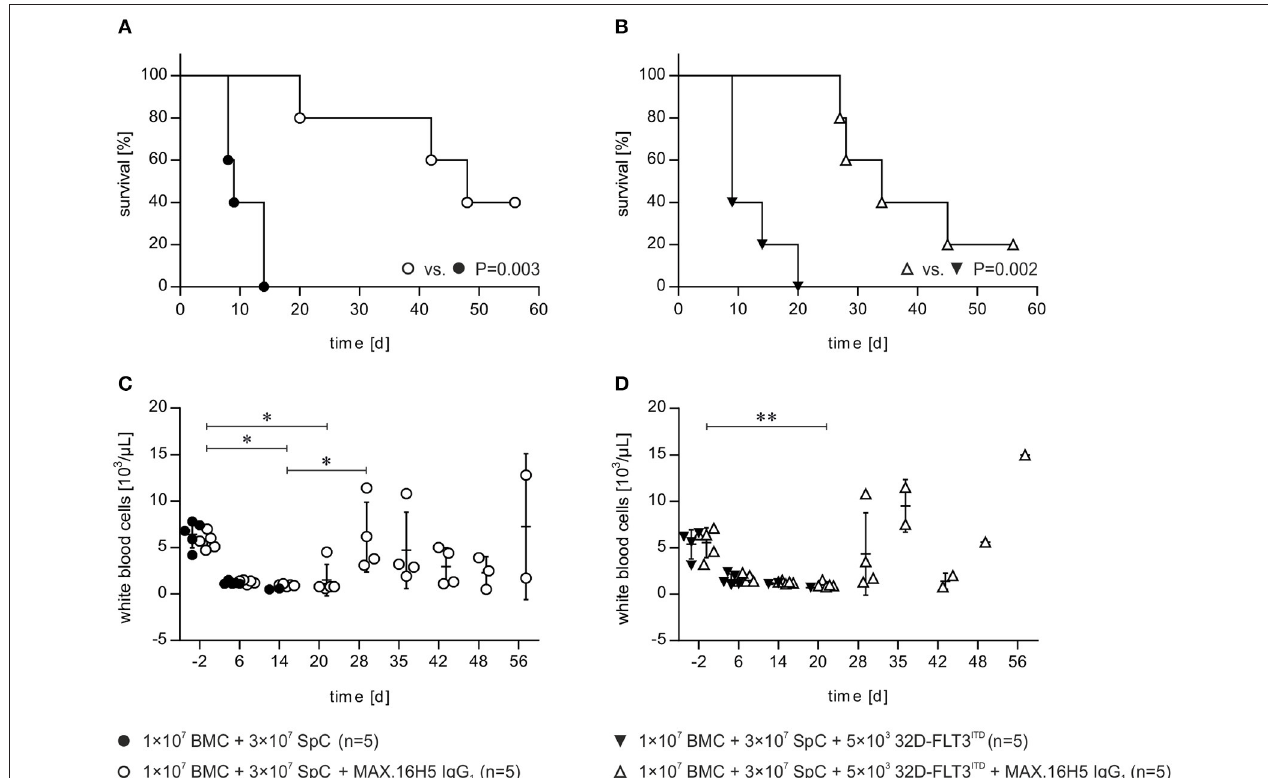
FIGURE 1 | Short-term pre-incubation of bone marrow and spleen cell grafts with MAX.16H5 IgG 1 antibody prolonged survival of C3H/HeN recipient mice after allogeneic transplantation either with or without co-transplantation of 32D-FLT3 ITD AML cells. All C3H/HeN mice received 1 × 10 7 bone marrow cells (BMC) and 3 × 10 7 spleen cells (SpC) as an allogeneic transplant in these experiments. (A) Survival of recipient mice after allogeneic transplantation. The grafts were pre-incubated either with MAX.16H5 IgG 1 or without antibody before administration to the recipients. C3H/HeN animals receiving a MAX.16H5 IgG 1 pre-incubated graft ( n = 5, open circles) showed a significantly prolonged survival compared to animals receiving an untreated graft ( n = 5, closed circles, P = 0.003; Log-Rank test). (B) Survival of C3H/HeN recipient mice receiving short-term pre-incubated (with or without MAX.16H5 IgG 1 antibody) grafts together with 5 × 10 3 32D-FLT3 ITD AML cells. C3H/HeN animals receiving a MAX.16H5 IgG 1 pre-incubated graft together with 32D-FLT3 ITD cells ( n = 5, open triangle) showed a statistically significant prolonged survival compared to animals receiving an antibody untreated graft ( n = 5, closed triangle, P = 0.002; Log-Rank test). (C) Reconstitution of white blood cells in the blood of C3H/HeN mice which received either MAX.16H5 IgG 1 pre-incubated grafts ( n = 5, open circle) or grafts without prior antibody incubation ( n = 5, closed circles). (D) White blood cell counts in the blood of C3H/HeN mice receiving bone marrow and spleen cell grafts either pre-incubated with MAX.16H5 IgG